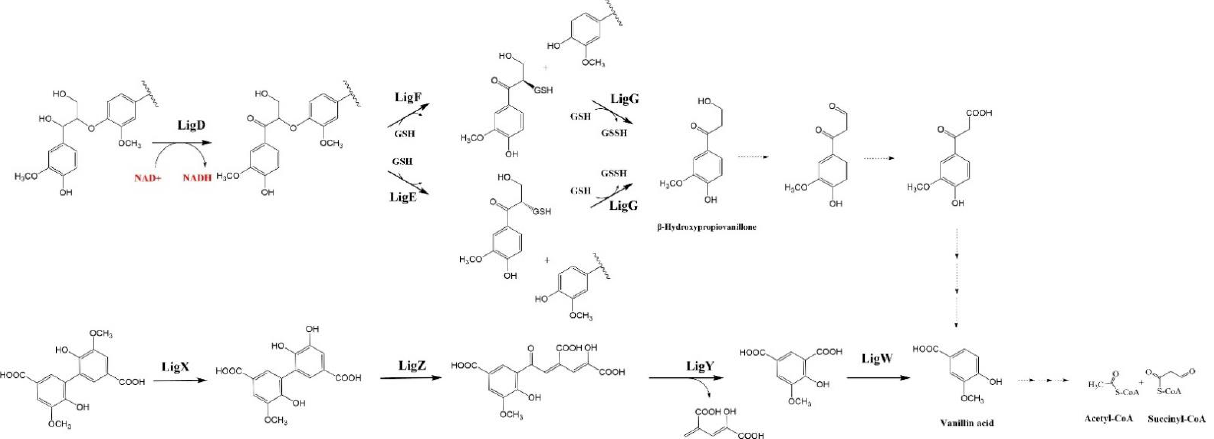
Figure 4. The β - Aryl ether (β -O-4) catabolic pathway and biphenyl linkage catabolic pathway. The enzymes involved in the β - Aryl ether (β -O-4) catabolic pathway and the biphenyl linkage catabolic pathway are from Sphingobium sp. SYK6 [73,77]. The β -Hydroxypropiovanillone and vanillin acid, which are produced from β -O-4 catabolic pathway and biphenyl linkage catabolic pathway, could be utilized for further valorization (showed in dotted arrows) [78,79].